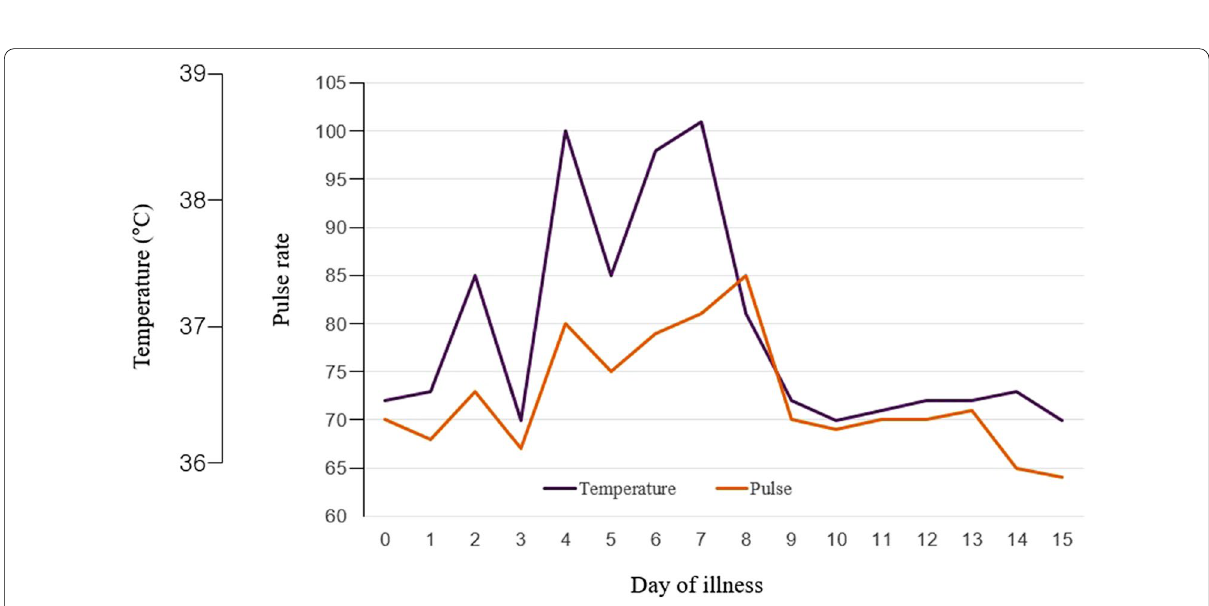
Fig. 3 Vital sign chart in patient with COVID‑19 (#125, median